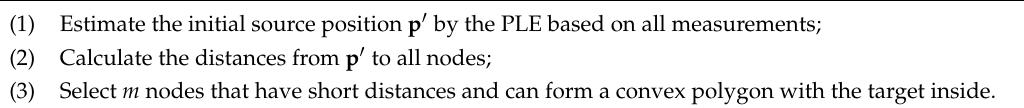
Algorithm 1. Selection method of reference nodes.